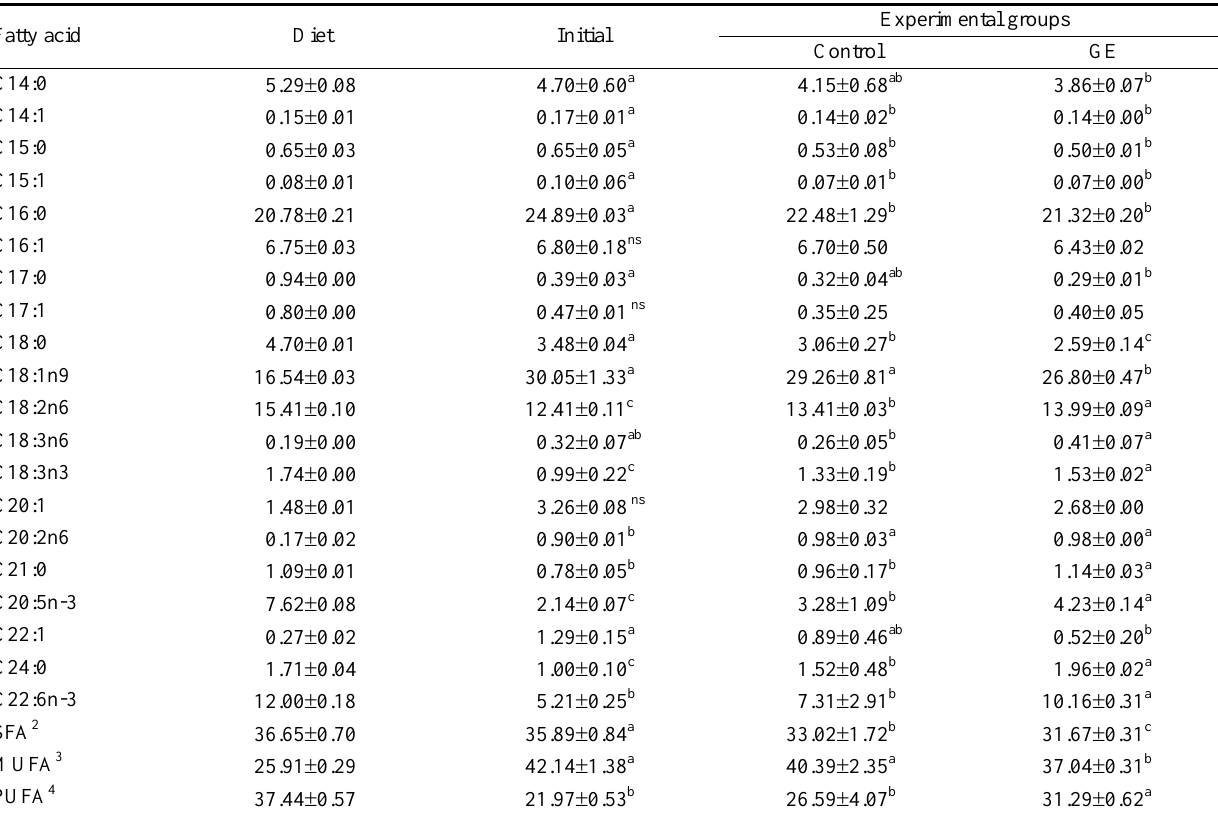
Table 4. Fatty acid profile (% of total fatty acids) in the experimental diet and whole body of initial and final fish fed diets for 5 wks 1